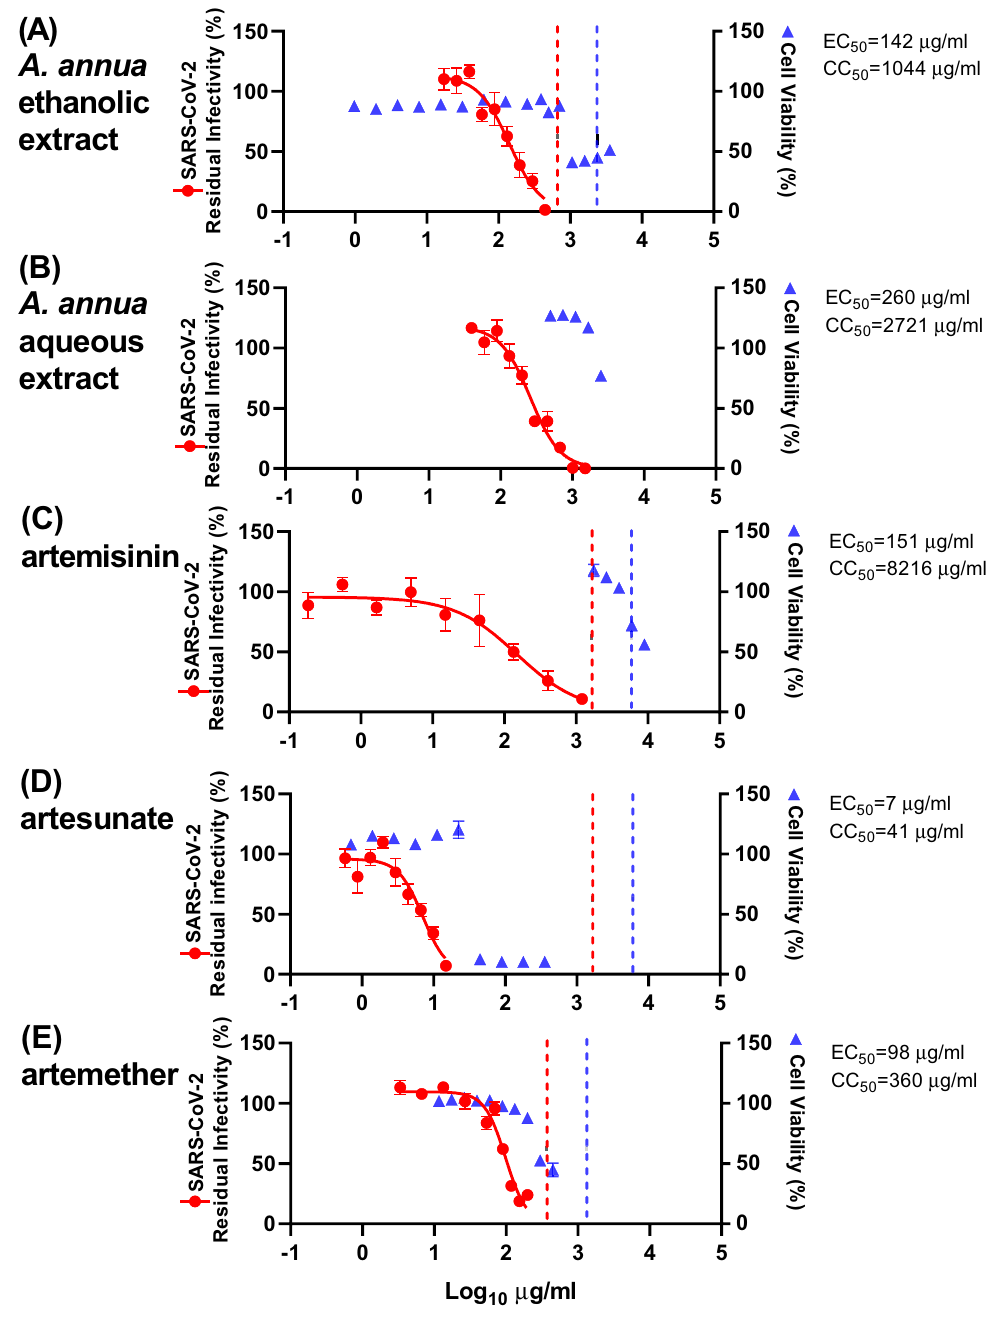
Figure 3. Treatment efficacy of extracts and compounds against SARS-CoV-2 in a concentration–response antiviral treatment assay in VeroE6 cells. VeroE6 cells seeded the previous day in 96-well plates were infected with SARS-CoV-2 and after 1 h incubation treated with the specified concentrations of extracts ( A ) A. annua ethanolic extract, and ( B ) A. annua aqueous extract or compounds artemisinin ( C ), artesunate ( D ), and artemether ( E ). After a 2-day incubation, infected cells were visualized by immunostaining for SARS- CoV-2 spike glycoprotein and counted automatically as described in “Materials and methods”. % residual infectivity for individual wells was calculated by relating counts of infected treated wells to the mean count of 14 infected nontreated control wells. Datapoints (red dots) are means of seven replicates with SEM obtained in one representative experiment. Sigmoidal dose response curves (red lines) were fitted and EC 50 values were calculated in GraphPad Prism as described in “Materials and methods”. % Cell viability and CC 50 values were determined in replicate assays without infection with SARS-CoV-2 as described in “Materials and methods”. Datapoints (blue triangles) are means of three replicates with SEM obtained in one representative experiment. The dotted red/blue lines indicate the concentrations at which an antiviral effect (< 70% residual infectivity)/ cytotoxic effect (< 90% cell viability) due to DMSO is expected according to Figure